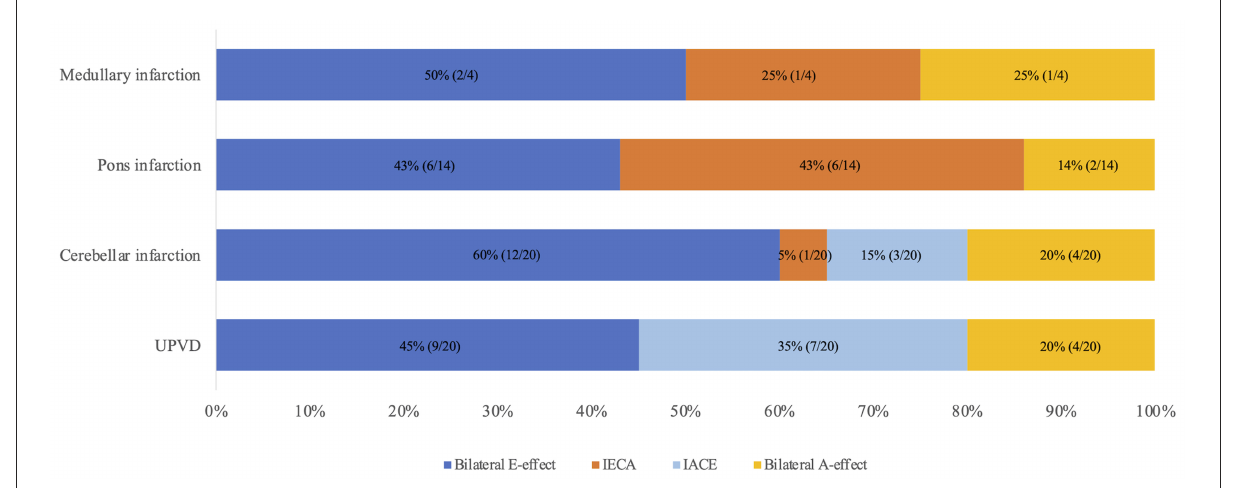
FIGURE5 Distribution of A/E-effects of head tilt SVV ( ± 45 ◦ ) in medullary, pons, cerebellum, and UPVD groups. IECA, Ipsilesional E-effect contralesional A-effect; IACE, Ipsilesional A-effect contralesional E-effect; UPVD, unilateral peripheral vestibular